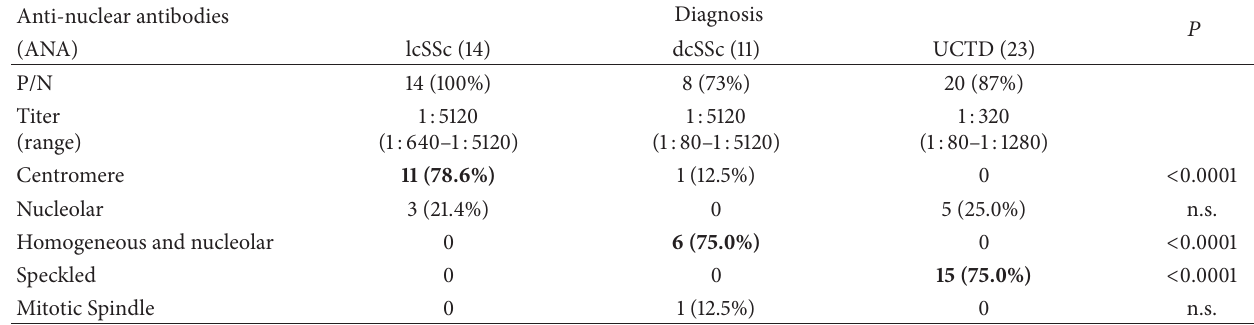
Table 2: Frequency of anti-nuclear antibodies and fluoroscopic patterns.